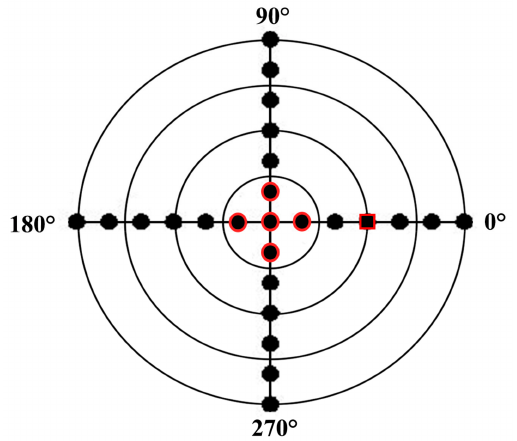
Figure 3. Same as Figure 1, but for the sufficient multi-angular observations (solid circles) and insufficient observations (red open points). The red open square refers to the direction of